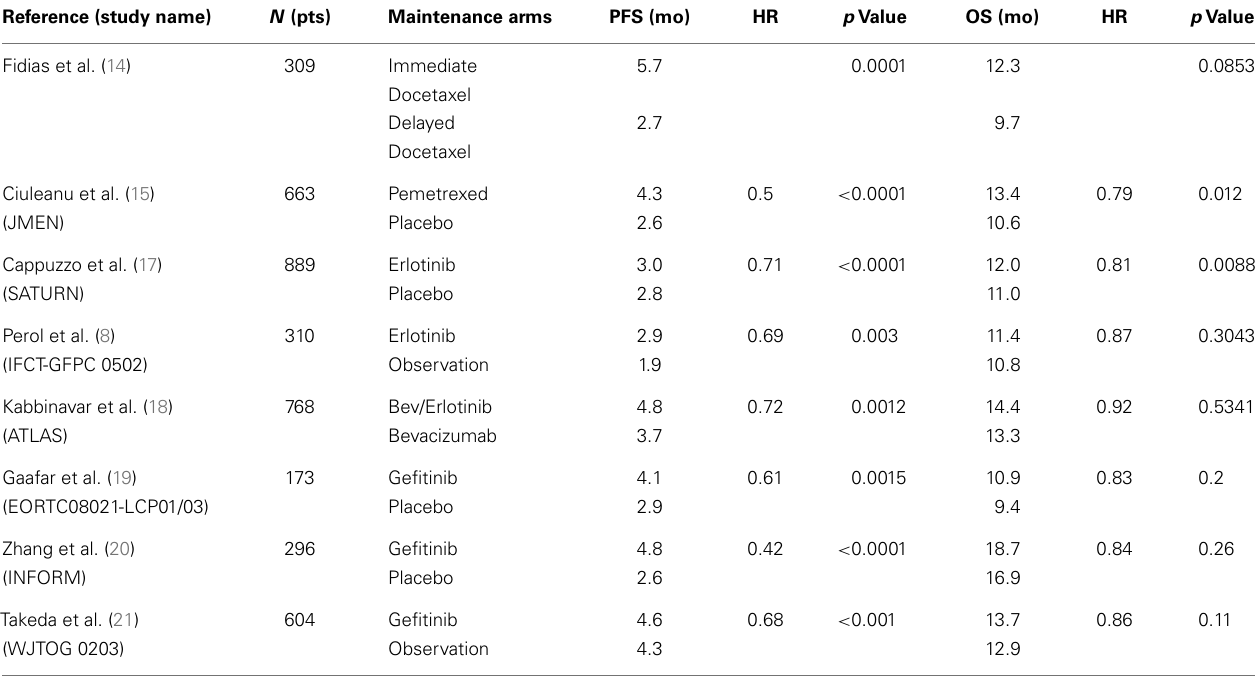
Table 2 | Key studies evaluating switch maintenance